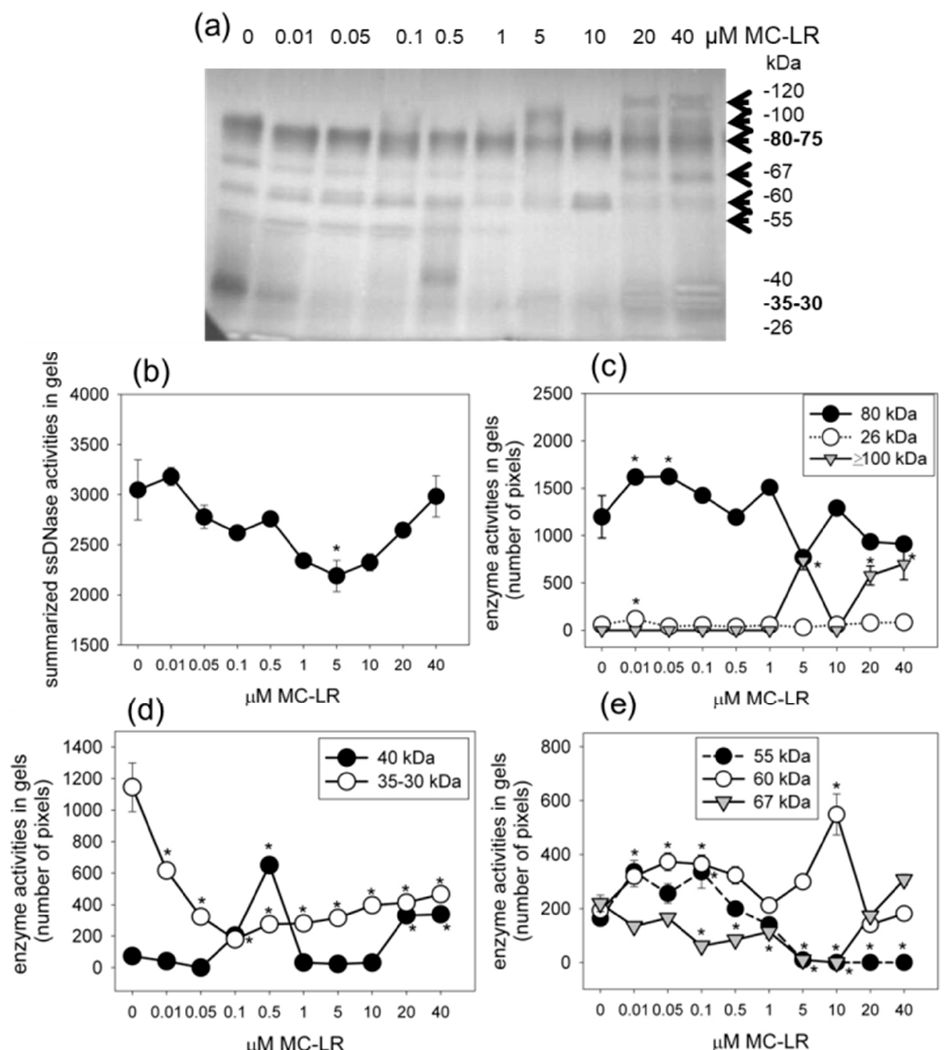
Figure 3. The dose-dependent effects of MC-LR on acidic (assayed at pH 5.5) single-stranded DNase (SSP nuclease) activities of whole S. alba seedlings after 4 days of exposure. ( a ) The in-gel activity assay shows characteristic MC-LR-dependent changes of the 120–100, 80–75, 67, 60 and 55 kDa isoenzymes (arrows). Gel was incubated for 6 h at 39 ◦ C. ( b ) Quantification by the CP Atlas method based on activity gels of total acidic SSP nucleases shows their transient activity decrease. ( c – e ) MC-LR concentration-dependent changes in the activities of the ≥ 100 kDa, 80 kDa, 67 kDa, 60 kDa, 55 kDa, 40 kDa, 35 kDa and 26 kDa acidic SSP nuclease isoenzymes. * Indicates the activity differences of MC-LR treatments vs. controls at p < 0.05